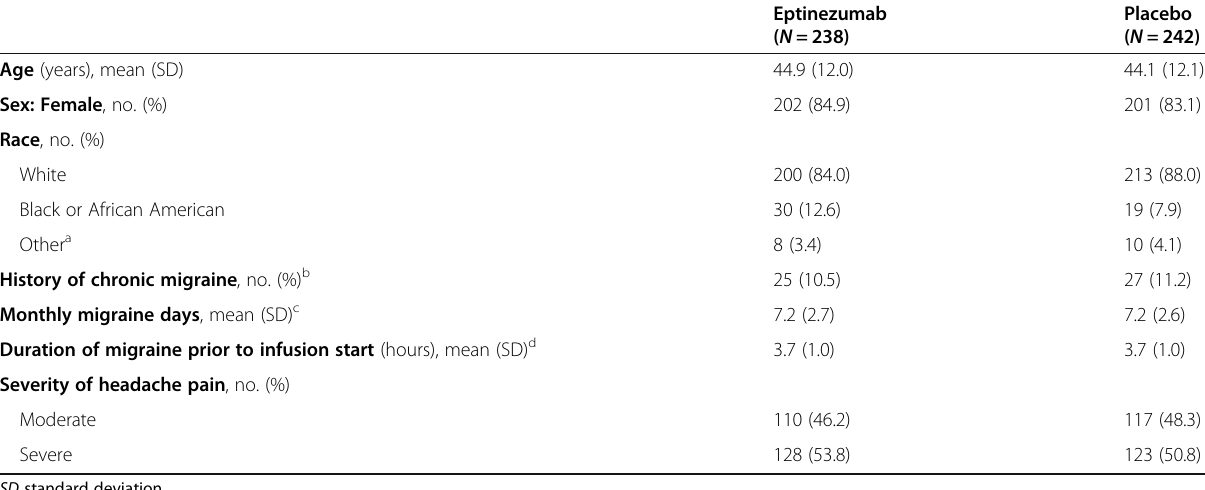
Table 1 Overview of demographics and baseline headache